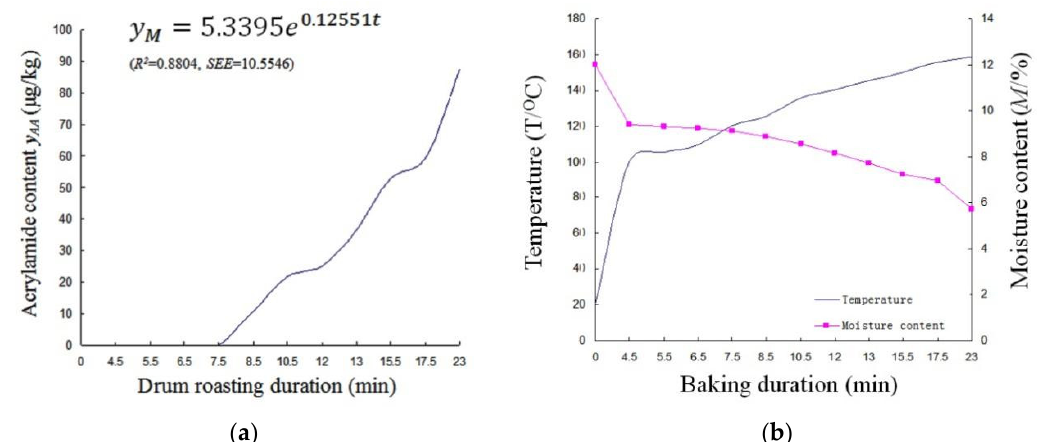
Figure 3. ( a ) Acrylamide content of adzuki beans during drum roasting. ( b ) Temperature and moisture content of adzuki beans with drum roasting.